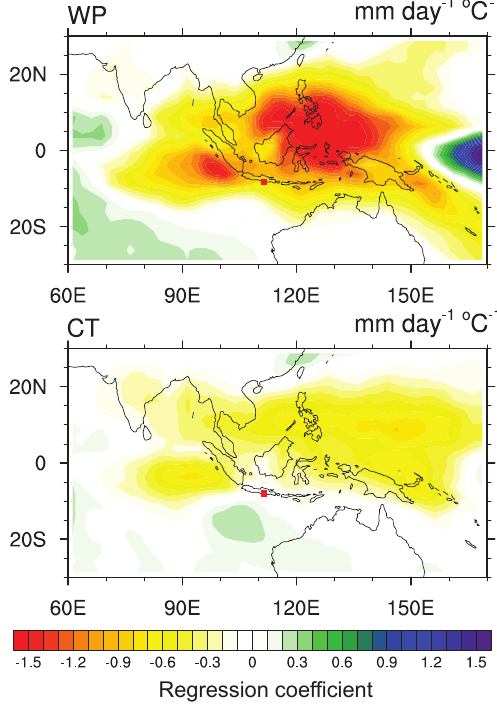
Figure 1. Regression coefficients (mm day − 1 ◦ C − 1 ) of monthly precipitation on the Warm Pool (WP) and the Cold Tongue (CT) ENSO index. The two indices are computed as per Ren and Jin (2011) (Eq. 1). Precipitation data are from the GPCP (Adler et al., 2003), for the period 1987–2010. The tree-ring site is marked with a red